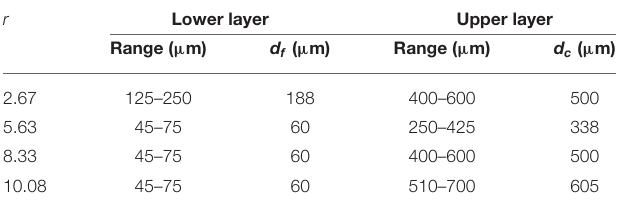
TABLE 1 | Particles used for two-layer beds with mono-sized